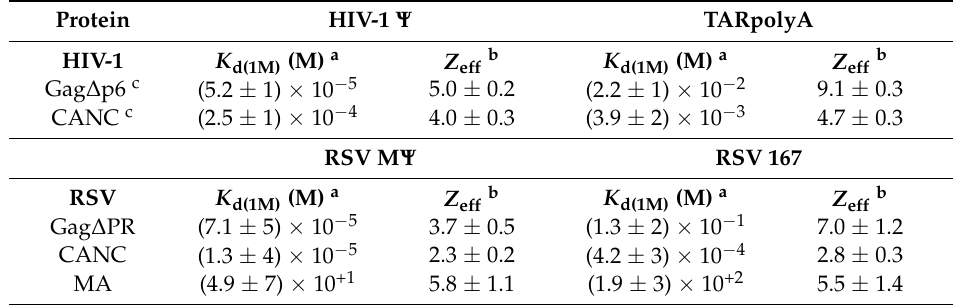
Table 1. Binding parameters determined from fluorescence-anisotropy (FA) salt-titration assays with Rous sarcoma virus (RSV) Gag ∆ PR and human immunodeficiency virus type 1 (HIV-1) Gag ∆ p6